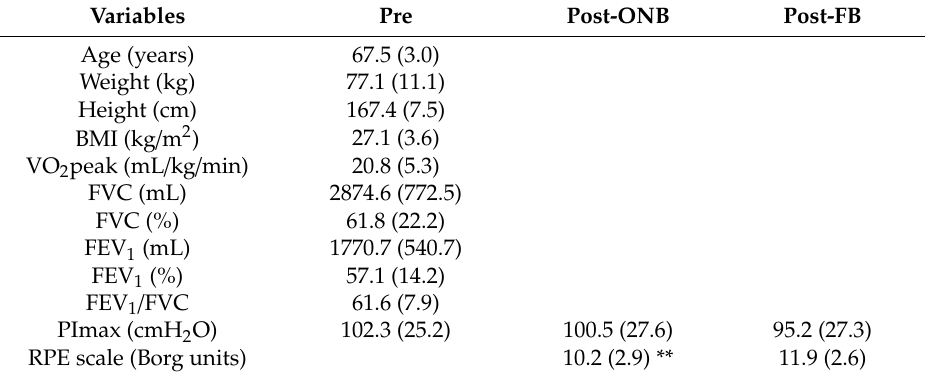
Table 1. Descriptive characteristics and pulmonary function of the sample. Values of P Imax and RPE after the 10 min walk test without FeelBreathe (post oronasal breathing (ONB)) and with FeelBreathe (post